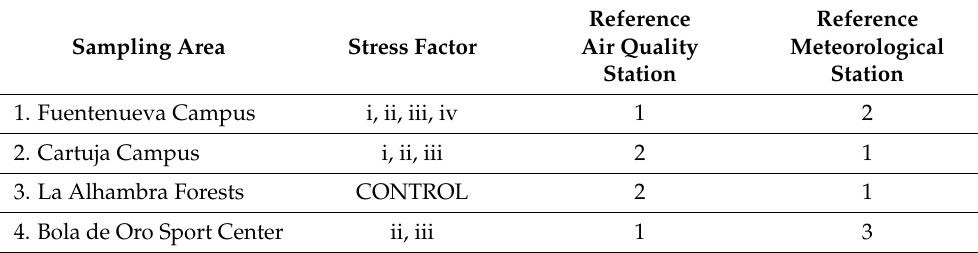
Table 1. Sampling areas in the city of Granada. The reference station of the Surveillance and Control Network of Air Quality and of the State Meteorological Agency are indicated with